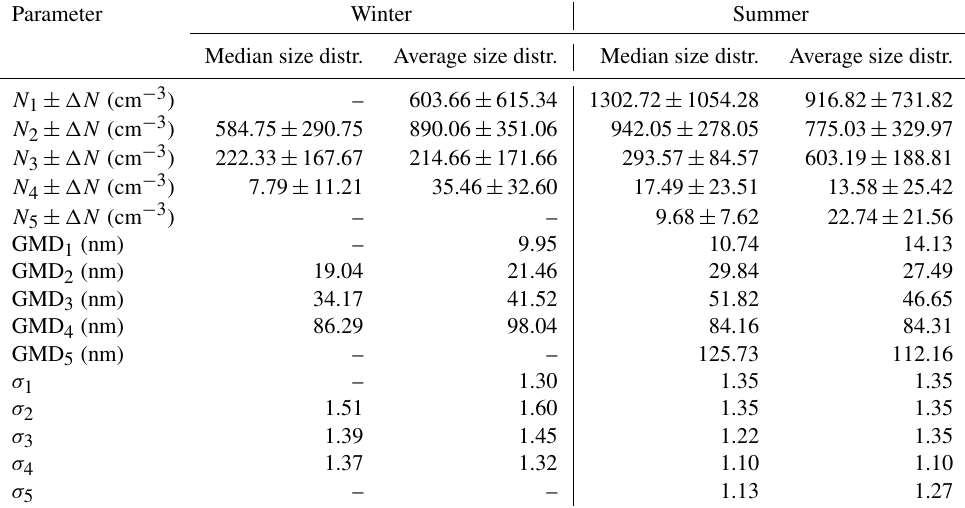
Table 4. Log-normal fit parameters for the average and median size distribution of the detected ship emission particles, during winter ( n = 61) and summer ( n = 8)